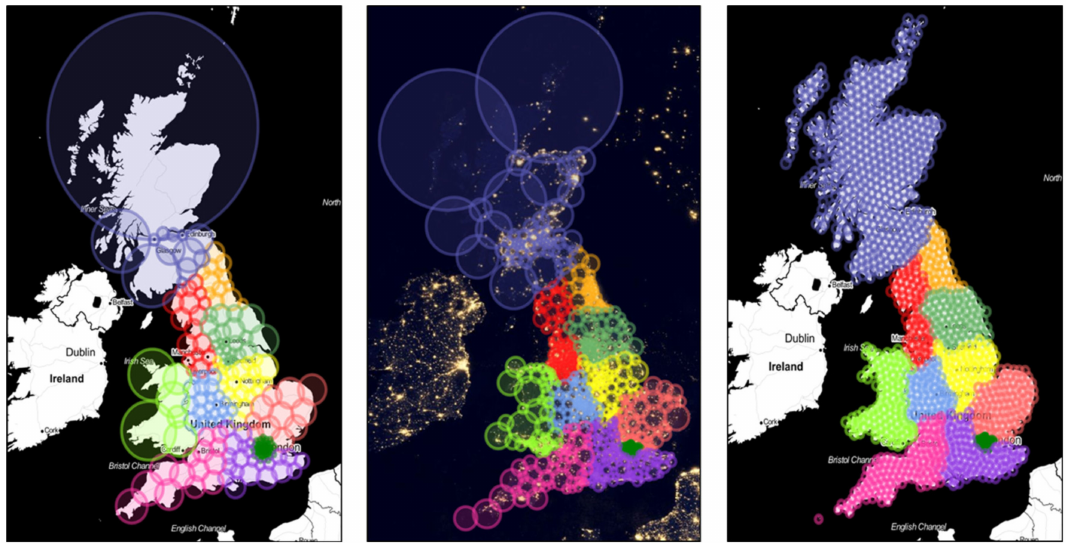
Figure 3. The “theory of circles” applied according to M1 ( left ), M2 ( center ), and M3 ( right